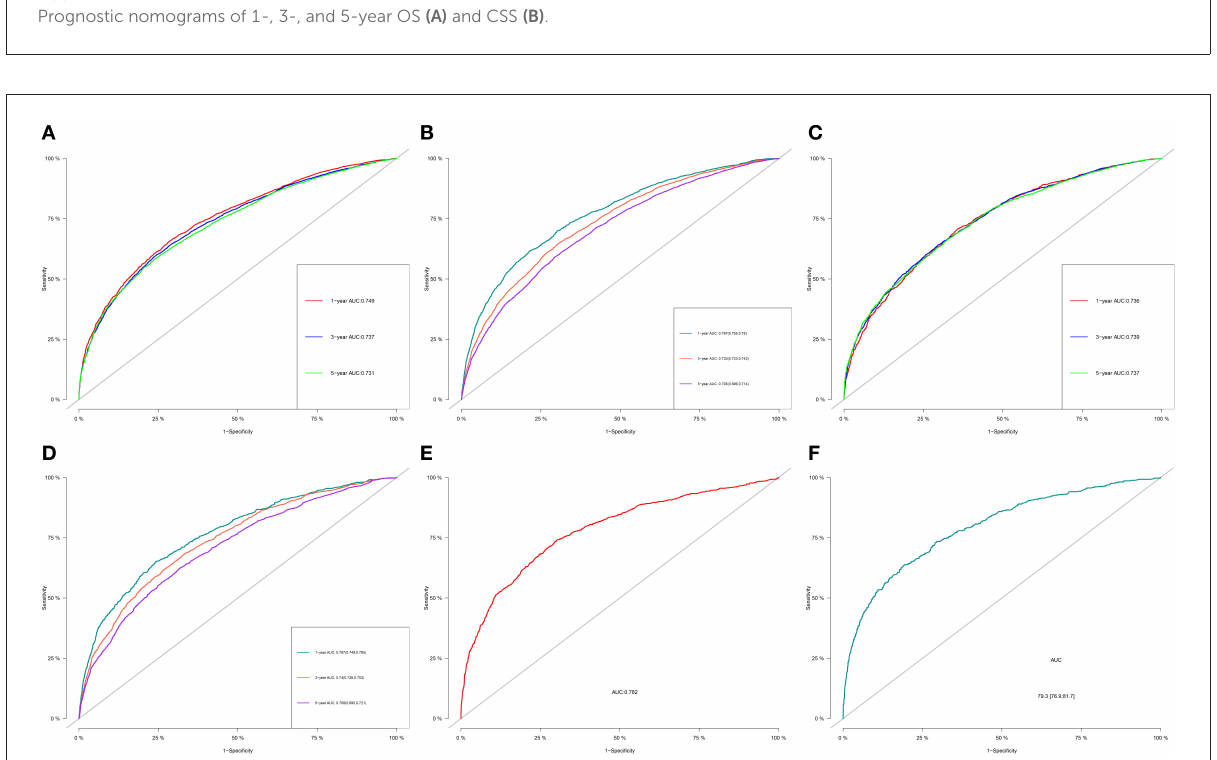
FIGURE3 1-, 3-, and 5-year ROC curves of OS and CSS in training group (A,B) , validation group (C,D) and external validation group (E,F) for validating nomogram models.